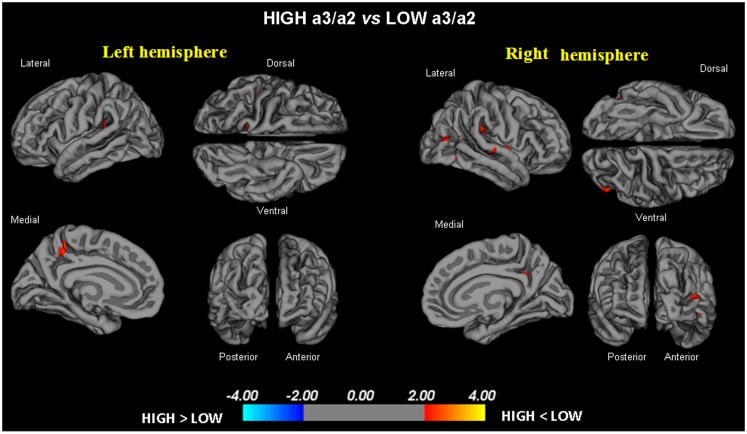
In red are represented the brain regions with higher regional cortical thickness in MCI with high a3/a2 ratio as compared to MCI with low a3/a2 ratio (p < 0.01 uncorrected). The color-coding for p-values is on a logarithmic scale. Results are presented on the pial cortical surface of brain: dark gray regions represent sulci and light gray regions represent gyri.